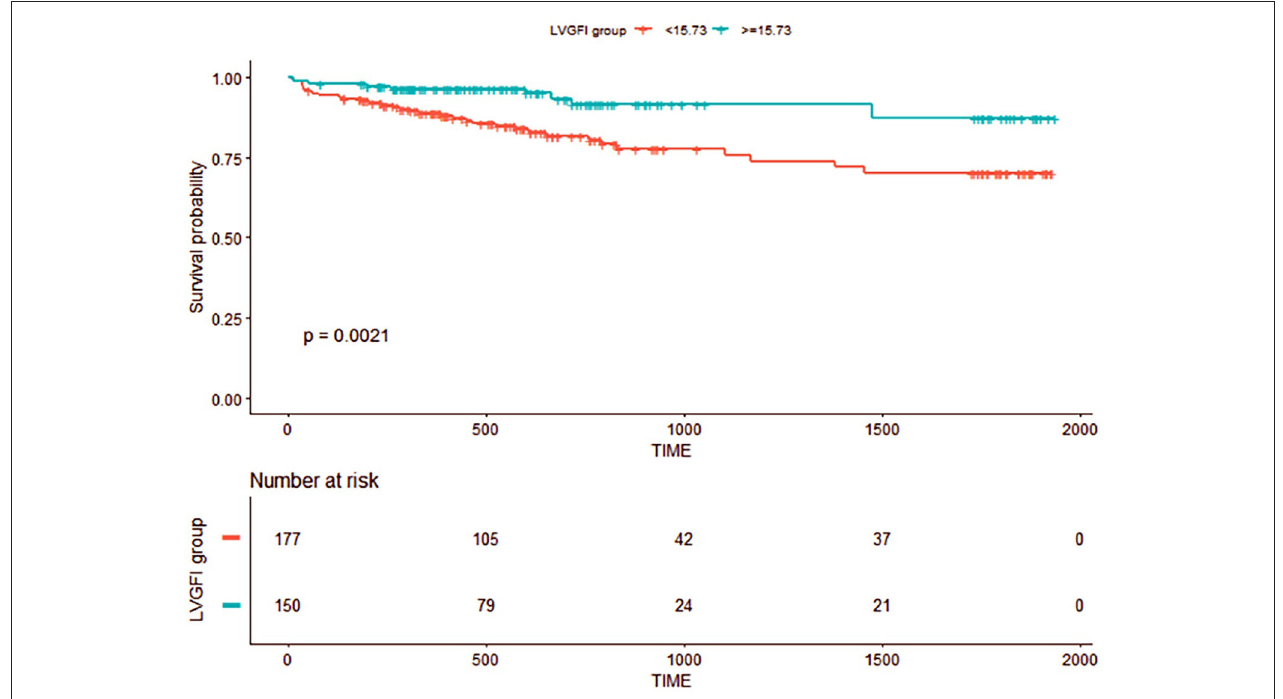
FIGURE 3 | Kaplan–Meier event-free survival curve. Numbers that do not add up to 334 are attributed to the missing data for